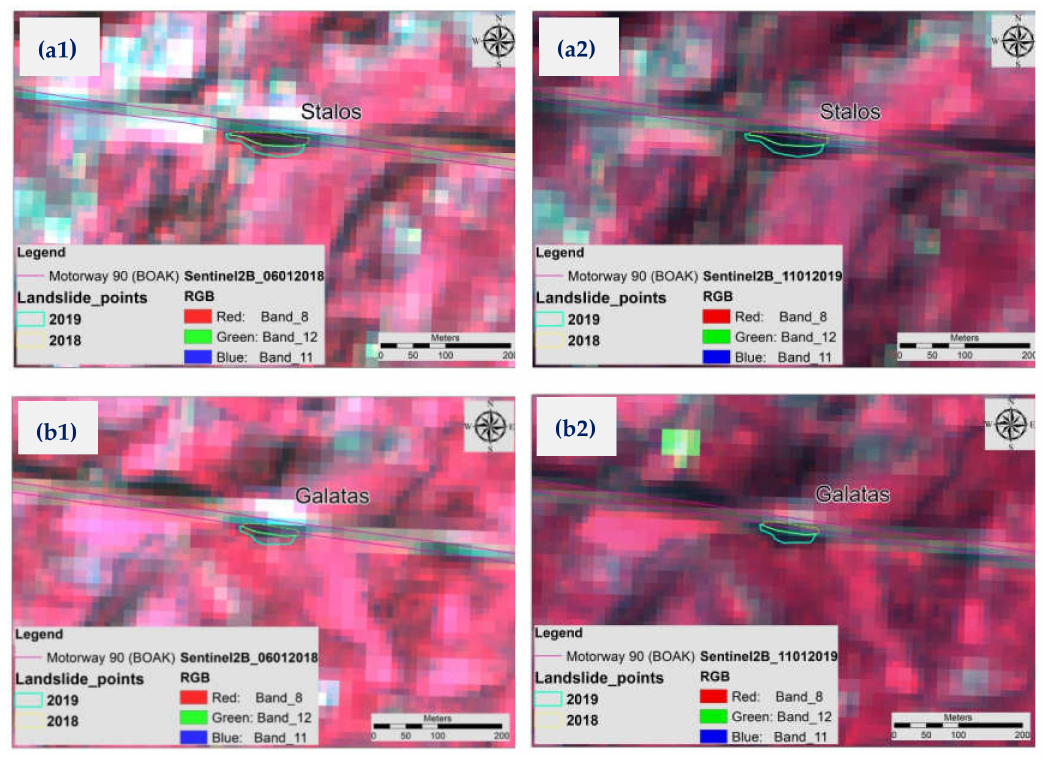
Figure 10. False color composites of Sentinel-2 pre ( a1 , b1 ) and post-landslide ( a2 , b2 ) events in Stalos and Galatas areas of motorway A90. Cyan polygons represent the landslide